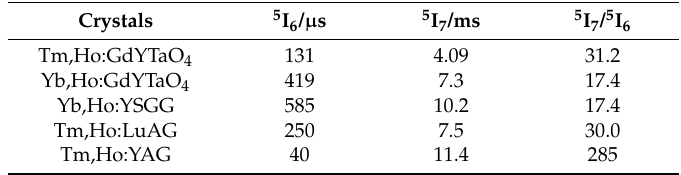
Table 5. Comparison of the lifetimes of 5 I 7 and 5 I 6 in different Ho 3+ -doped crystals [45–47].